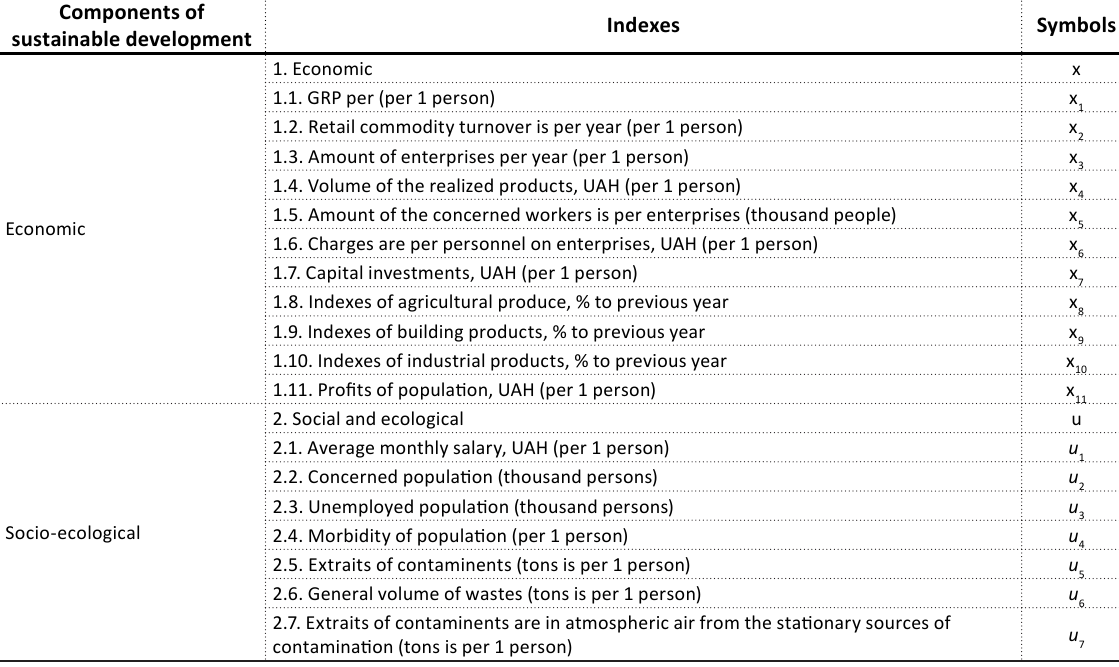
Source: Developed by the